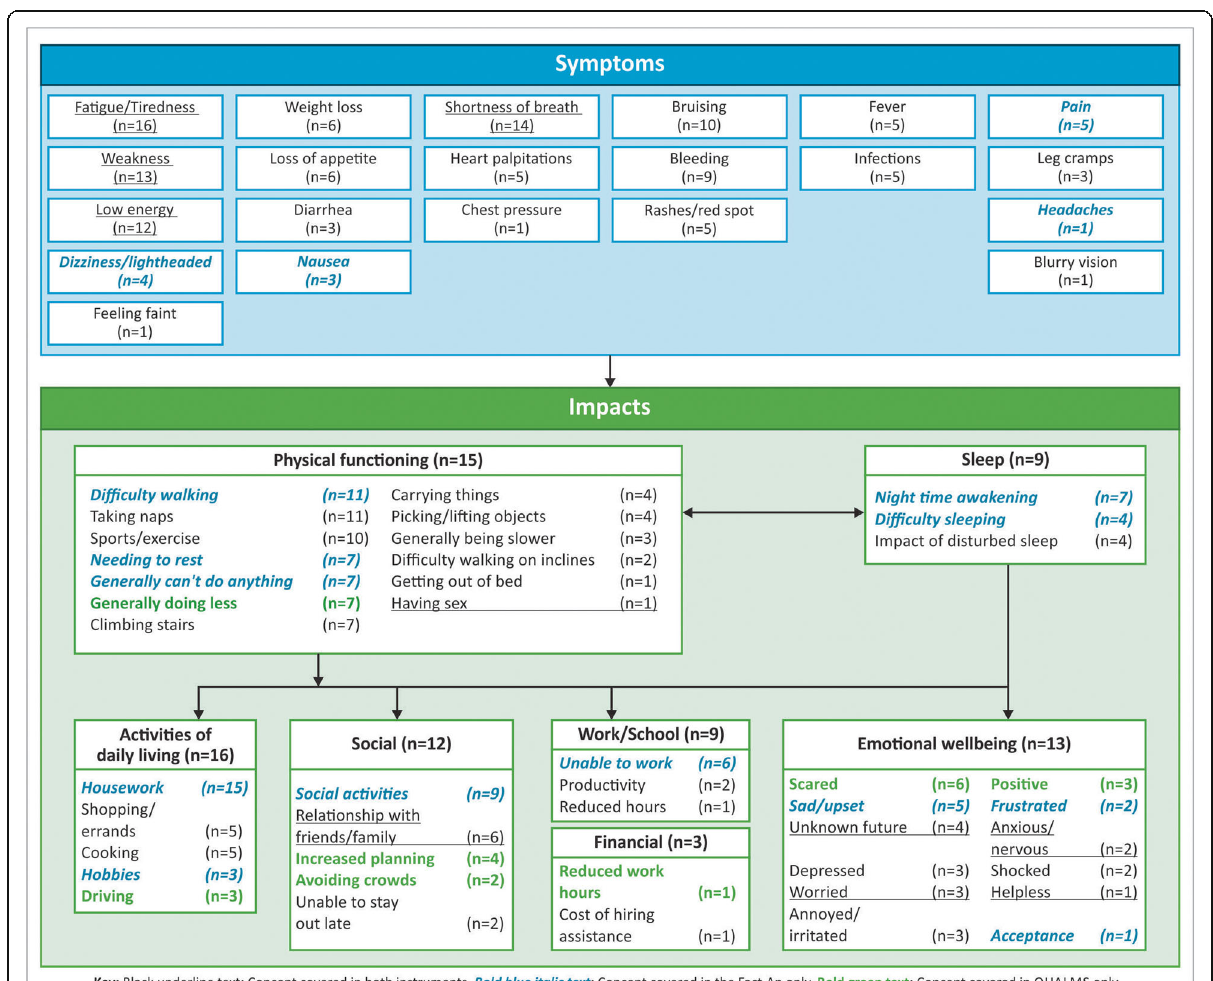
Fig. 1 Conceptual model of patients ’ experience with